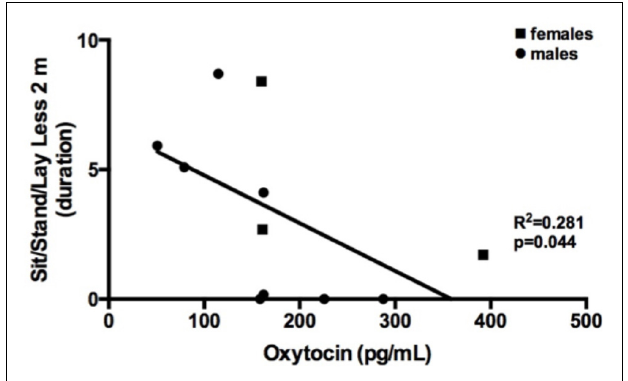
FIGURE 2 | Correlation between Standing, seating, laying less than 2 m away from the experimenters (relative duration) and plasma oxytocin (pg/mL).